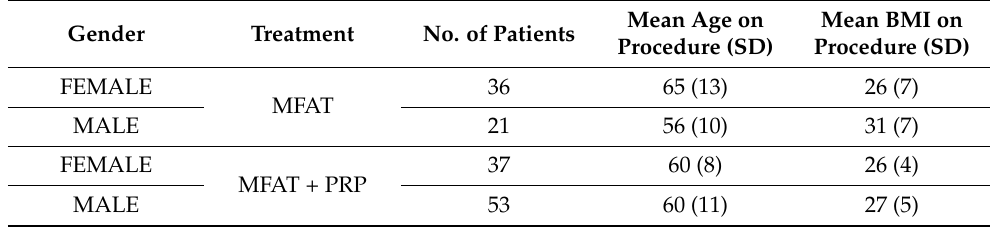
Table 1. Patient demographics. Age and BMI at the time of treatment.